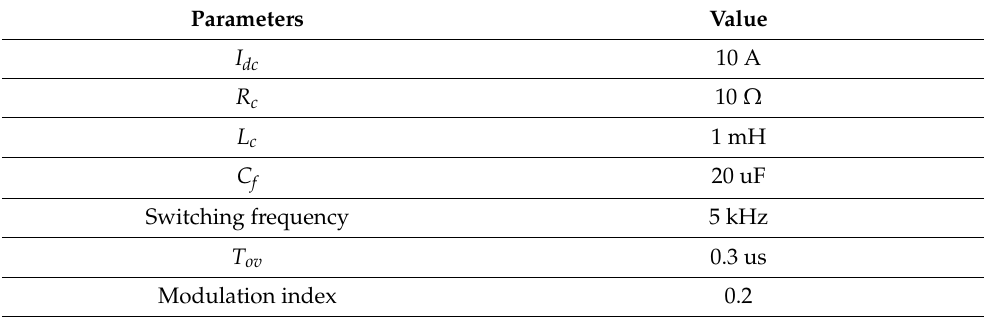
Table 5. Parameters of CSI.